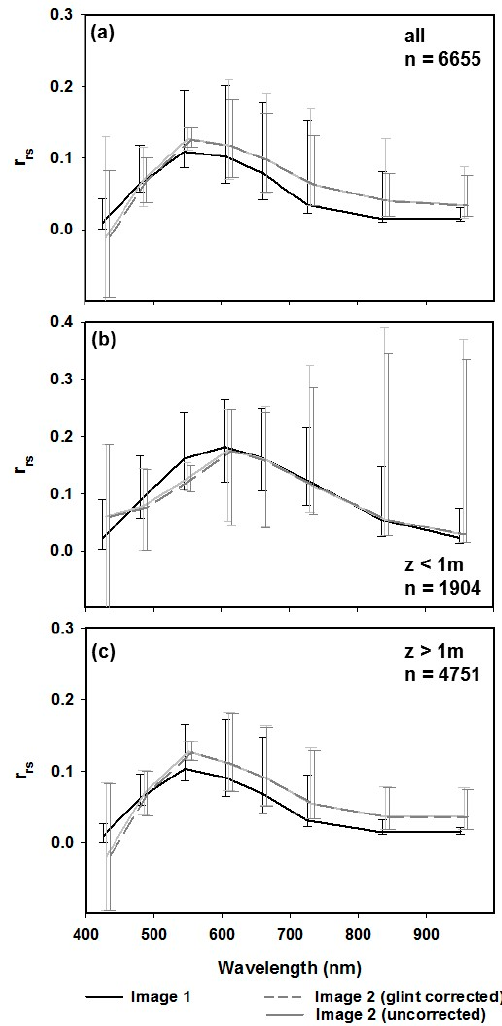
Figure 5. ( a ) Median and 5th and 95th percentiles r rs in each spectral band of a cross-track spectral profile, collected from each image (Image 1, Image 2 (uncorrected), and Image 2 (GC: glint corrected)) where in situ depth observations were collected (transect 1, Figure 2); ( b ) median and 5th and 95th percentiles r rs in each spectral band of all optically shallow (<1 m water depth) observations; and ( c ) mMedian and the 5th and 95th percentiles r rs in each spectral band of all optically deep (>1 m water depth) observations.